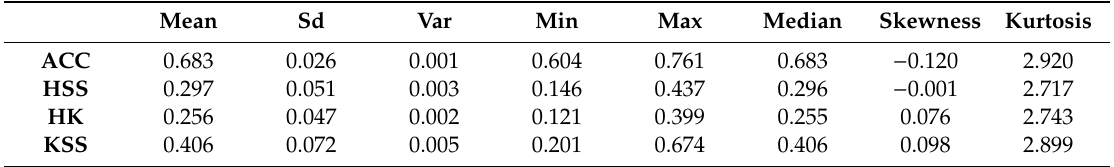
Table 3. Statistics for the scores of the Linear Discriminant Analysis (LDA)